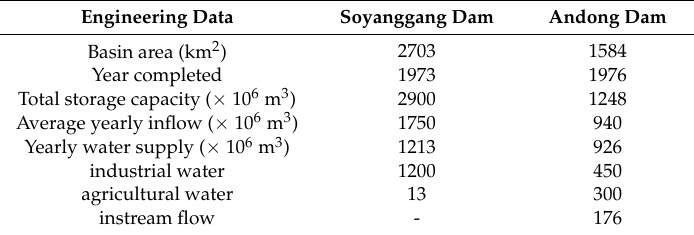
Table 2. Project data of two dams.